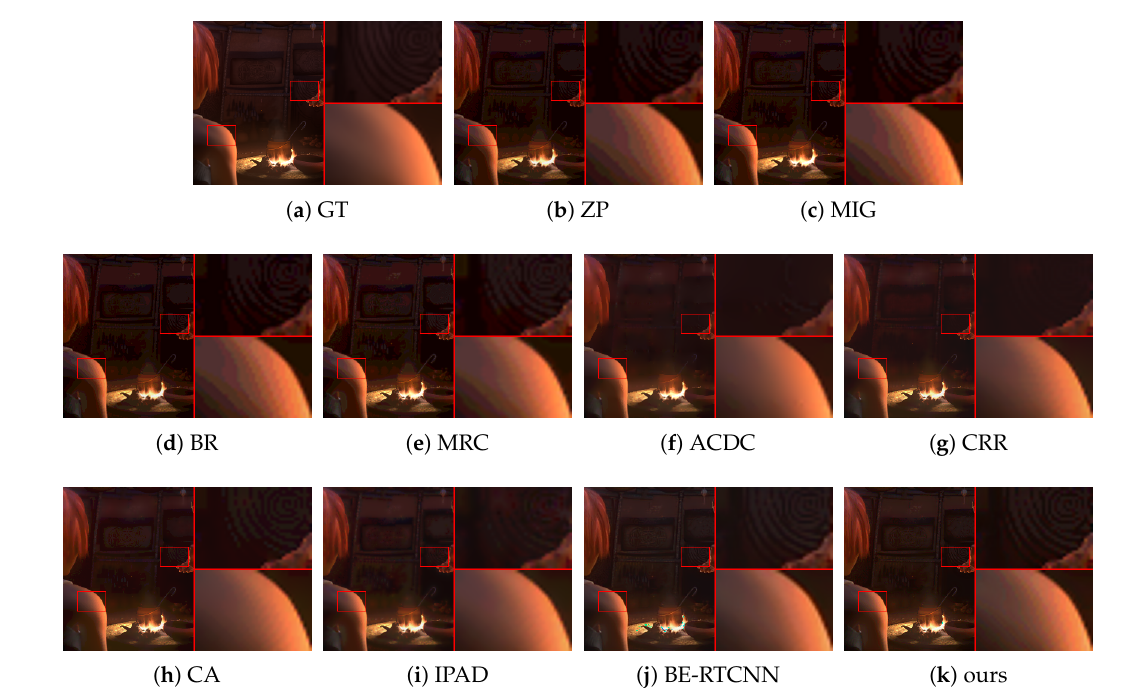
Figure 5. The BDE results on 4bit-16bit synthetic image from sintel-8